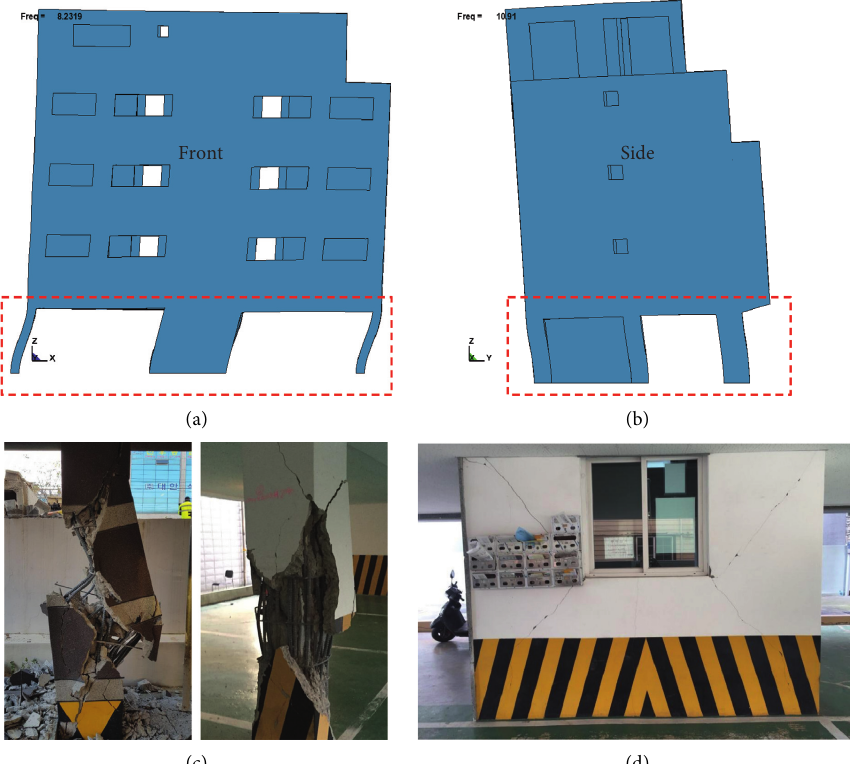
Figure 1: Examples of deformed shape and failure in columns and a wall on the 1 st floor of piloti-type buildings. (a) Front and side views of the deformed shapes of a five-story piloti-type building analysis model. (b) Shear failure examples in columns [1]. (c) A shear crack example on a wall